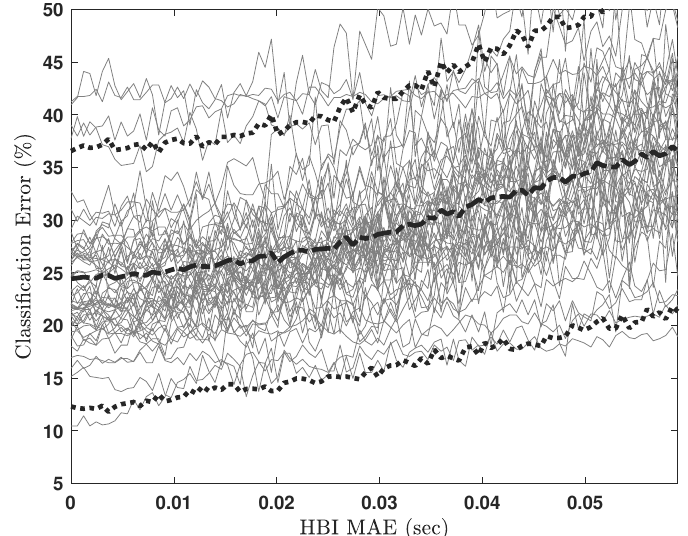
Figure 6. SVM classification error due to all HRV features for micro-labeled sleep stages. Light gray lines represent classification errors for each participant. The dashed, bold black line is the ensemble average, and the dotted bold lines show mean +/ − 1.96 standard deviations.